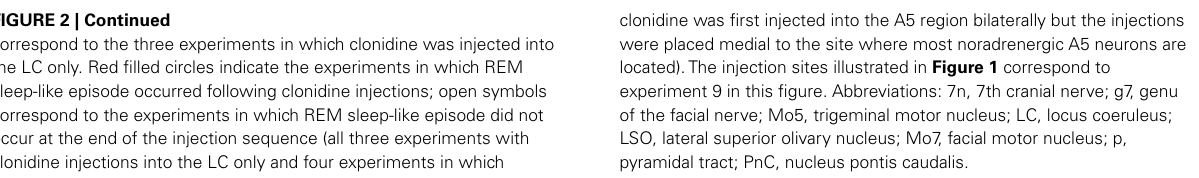
FIGURE 3 |A typical REM sleep-like episode elicited by carbachol injection into the dorsomedial pontine tegmentum while recording extracellularly from a noradrenergic cell of the LC. Characteristic of these episodes are reduction of low-frequency components in favor of higher frequencies (6–12Hz) in the power spectrum of cortical electroencephalogram (EEG), the appearance of theta-like rhythm in the hippocampus (HIPP; 3–4Hz under anesthesia;Vertes et al., 1993; c.f., graphs at the bottom), reduction of inspiratory activity of the hypoglossal (XII) nerve, and slowing of the respiratory rate.The top two traces show that, when these